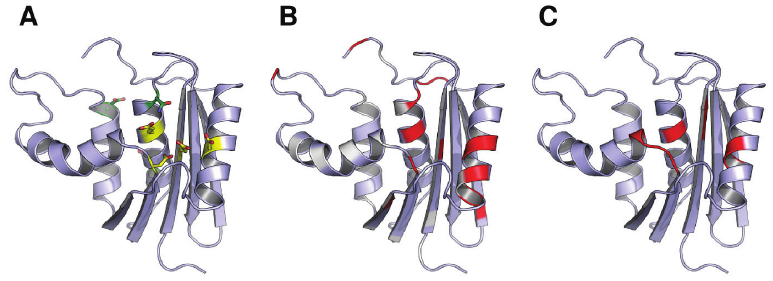
Figure 3. Experimental NMR measurements of the effects of Mg 2+ binding mapped onto the structure of ecRNH. ( A ) Active site residues (yellow) and other DENQ residues (green) that experience perturbation upon Mg 2+ binding 24 . ( B ) Chemical shift perturbation values for sidechain C γδ reflecting the effects of Mg 2+ binding 24 . White corresponds to no chemical shift change, red corresponds to a large change, and non-DENQ residues are shown in light blue. ( C ) Residues previously shown to experience backbone 15 N or 1 H chemical shift changes upon binding Mg 2+ 25